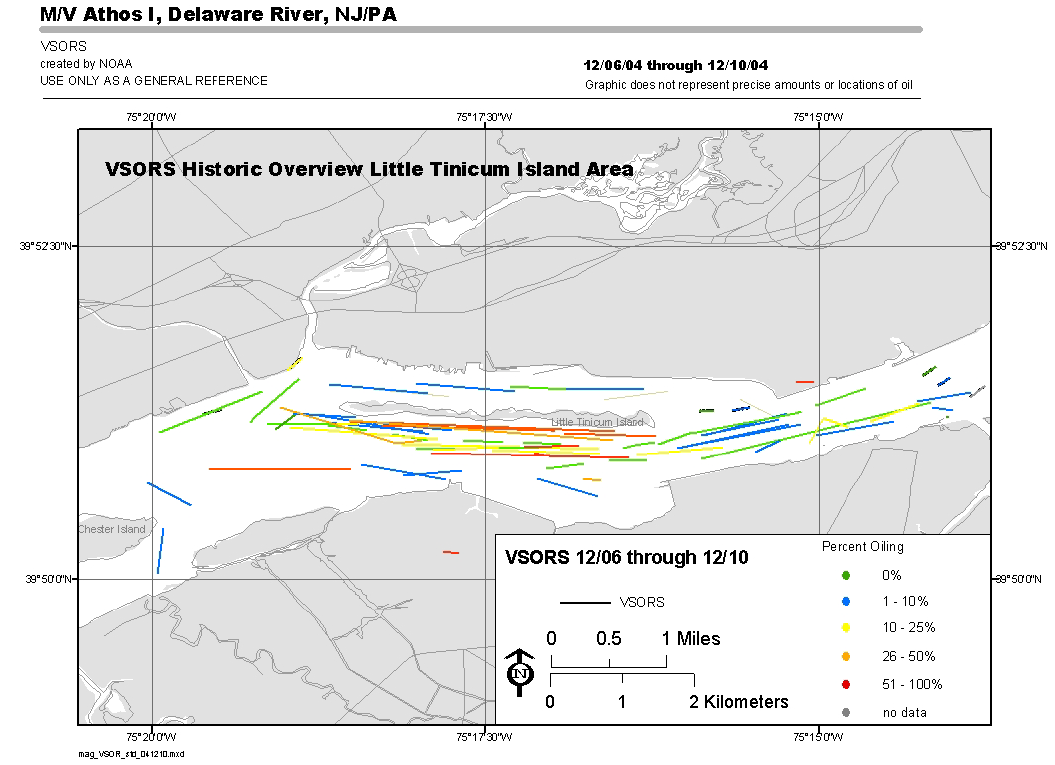
Figure 2. Available Vessel Submerged Oil Recovery System (VSORS) field data collected after the M/T Athos I oil spill. Map created by NOAA [30].